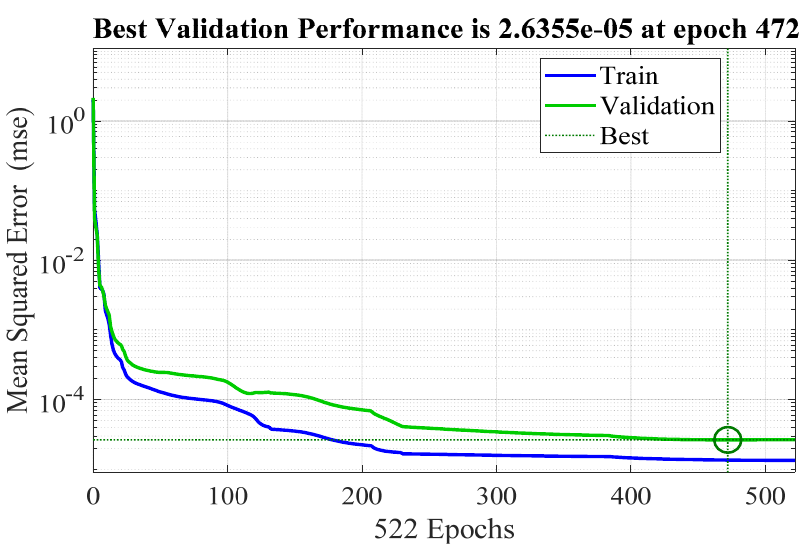
Figure 3. BP neural network mean square error loss graph.